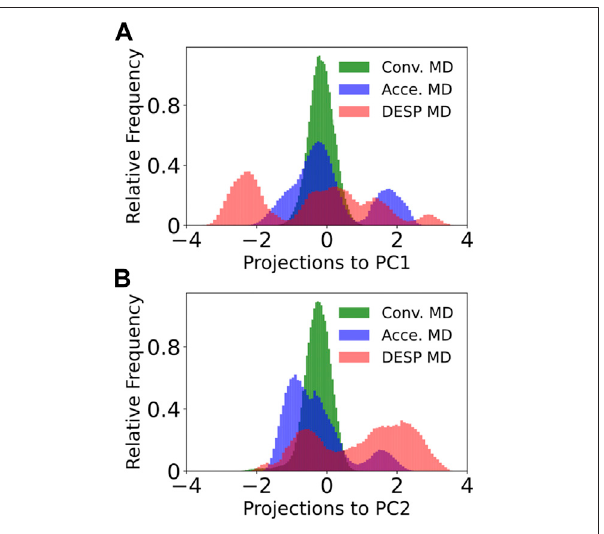
FIGURE 7 | Projections of the trajectory to the fi rst principal component for GB98(bottom). Theprojectionofeach ofthe framesintheDESPtrajectory into the PC1 ’ s space (A) and PC2 ’ s space (B) are shown for GB98. Similar projections for the A 12 molecular system do not offer additional information and are now shown here for